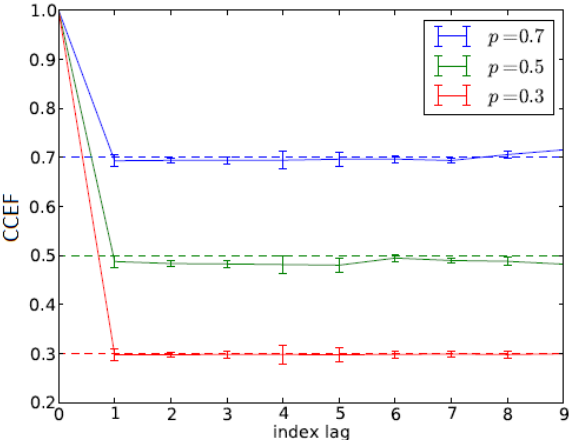
Figure 1. Mean CCEF for 10 indexed sets of random Erd˝os–Rényi networks with 100 nodes and different linking probabilities p . The dashed lines correspond to the analytical CCEF levels, the error bars give the 1 σ standard deviation for each index lag . to the expected value p .